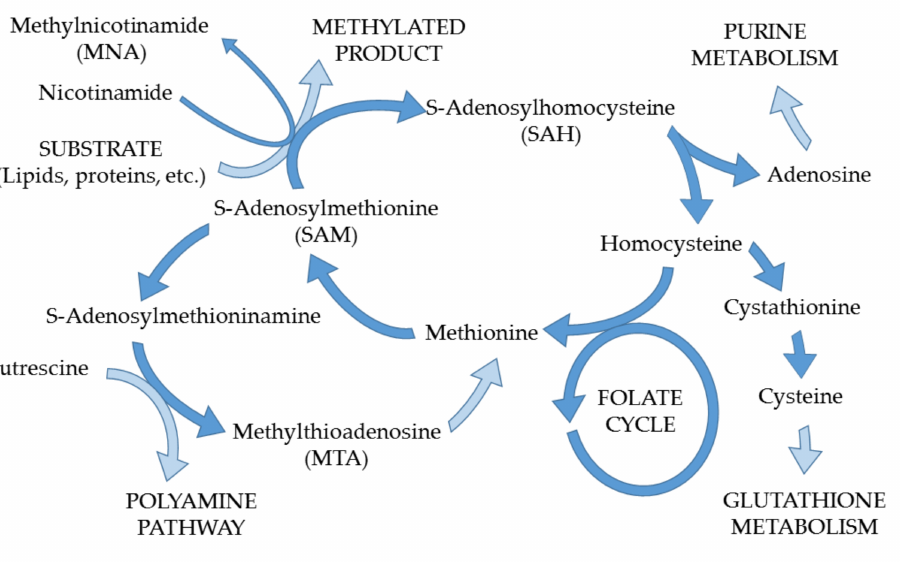
Figure 5. Scheme illustrating methylation process, potentially enhanced during BCa, along with related metabolic pathways. Based on